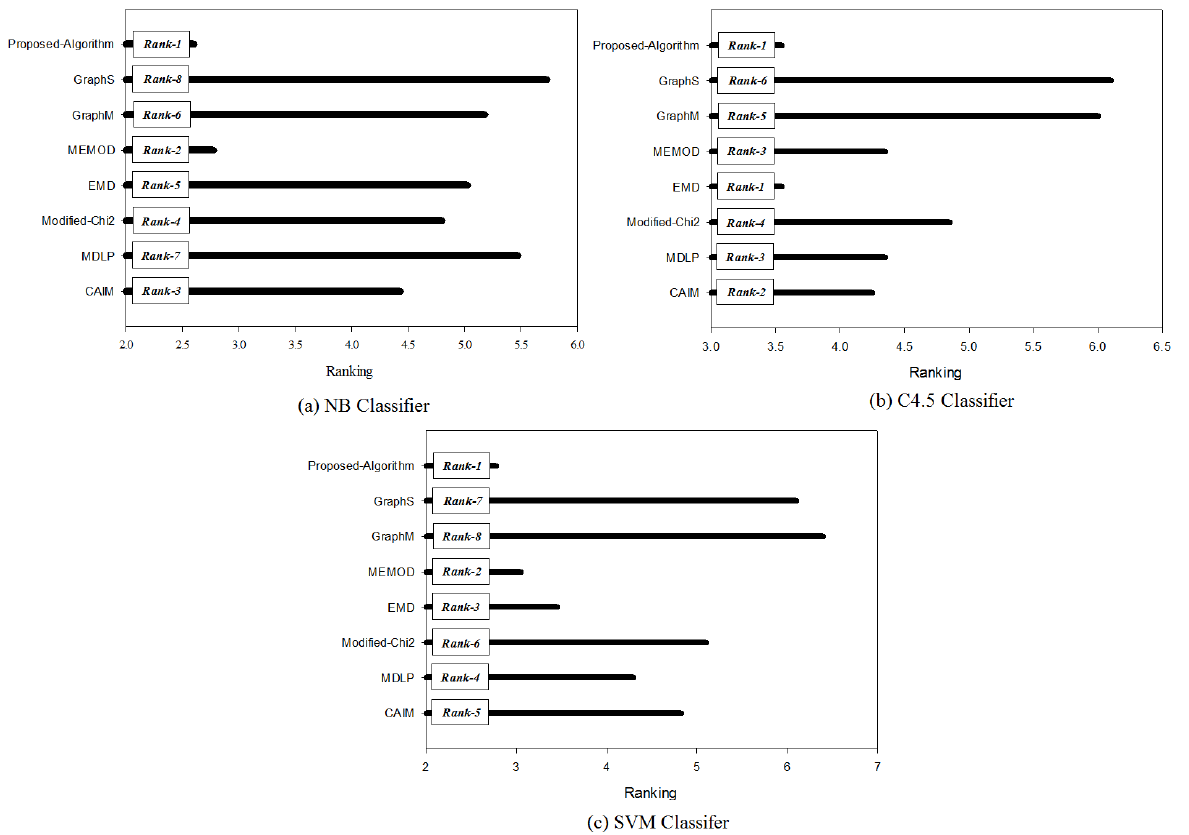
Figure 4. Average ranks obtained by each algorithm in the Friedman